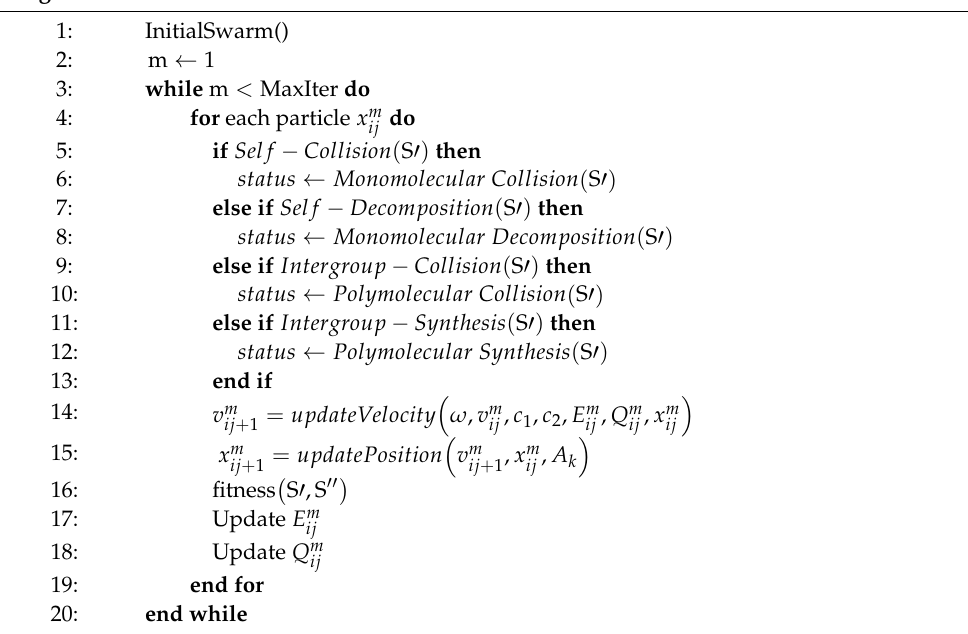
Algorithm 2 Pseudocode of